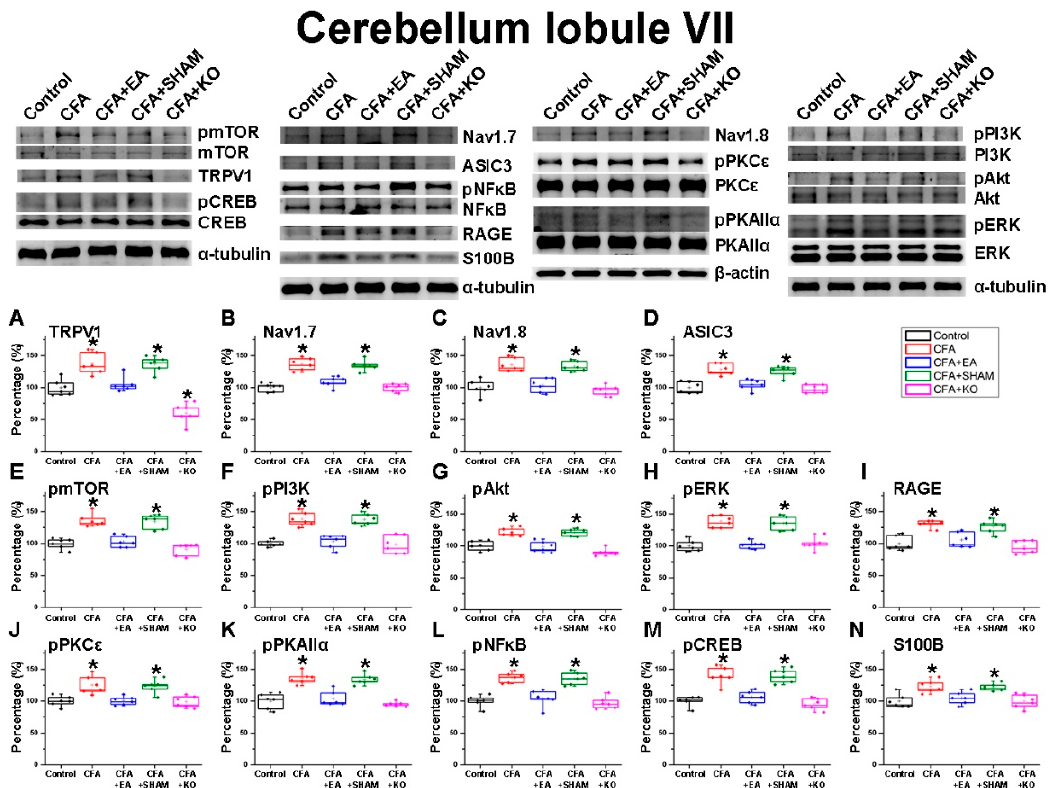
Figure 4. The expression levels of pain receptors and involved molecules in the cerebellum lobule VII. The immunoblotting images contain five lanes of protein in following order: control, CFA, CFA+EA, CFA+SHAM, and CFA+KO groups. There are significant decreases of ( A ) TRPV1, ( B ) Nav1.7, ( C ) Nav1.8, ( D ) ASIC3, ( E ) pmTOR, ( F ) pPI3K, ( G ) pAkt, ( H ) pERK, ( I ) RAGE, ( J ) pPKC ε , ( K ) pPKAII α , ( L ) pNF κ B, ( M ) pCREB and, ( N ) S100B protein level in CFA+EA and CFA + KO groups compared to